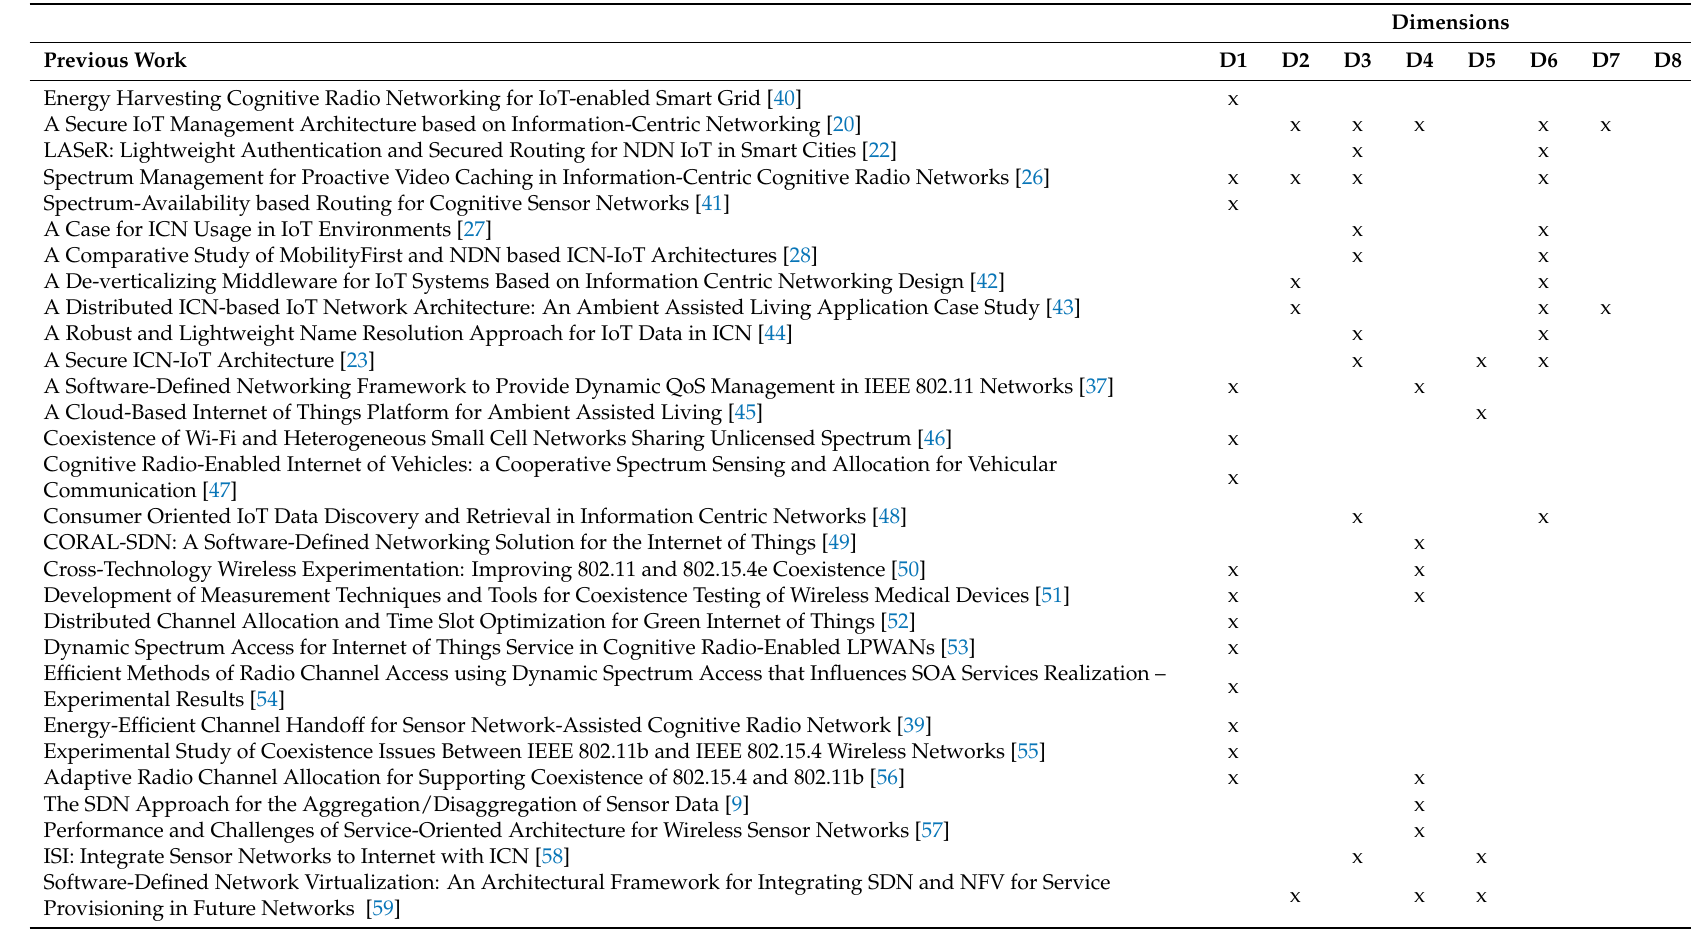
Table 2. Related work on the next generation WSANs and IoT networks. Comparison with respect to: D1—Dynamic spectrum management with cognitive radio; D2—Secure exchange of control data via trustable services; D3—Named-control-data access and routing; D4—Software-defined control and operation; D5—Dynamic composition of control services; D6—Improved naming and name resolution for IoT; D7—Identifier/locator splitting for architecture entities;